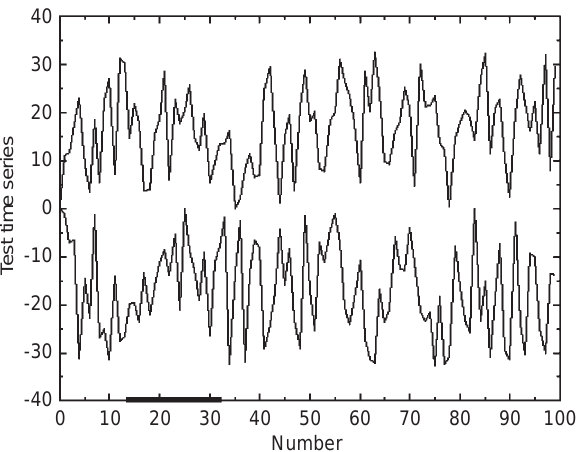
Fig. 3. Example of two random data series with selected dissimilarity segment (shown by the lower line )